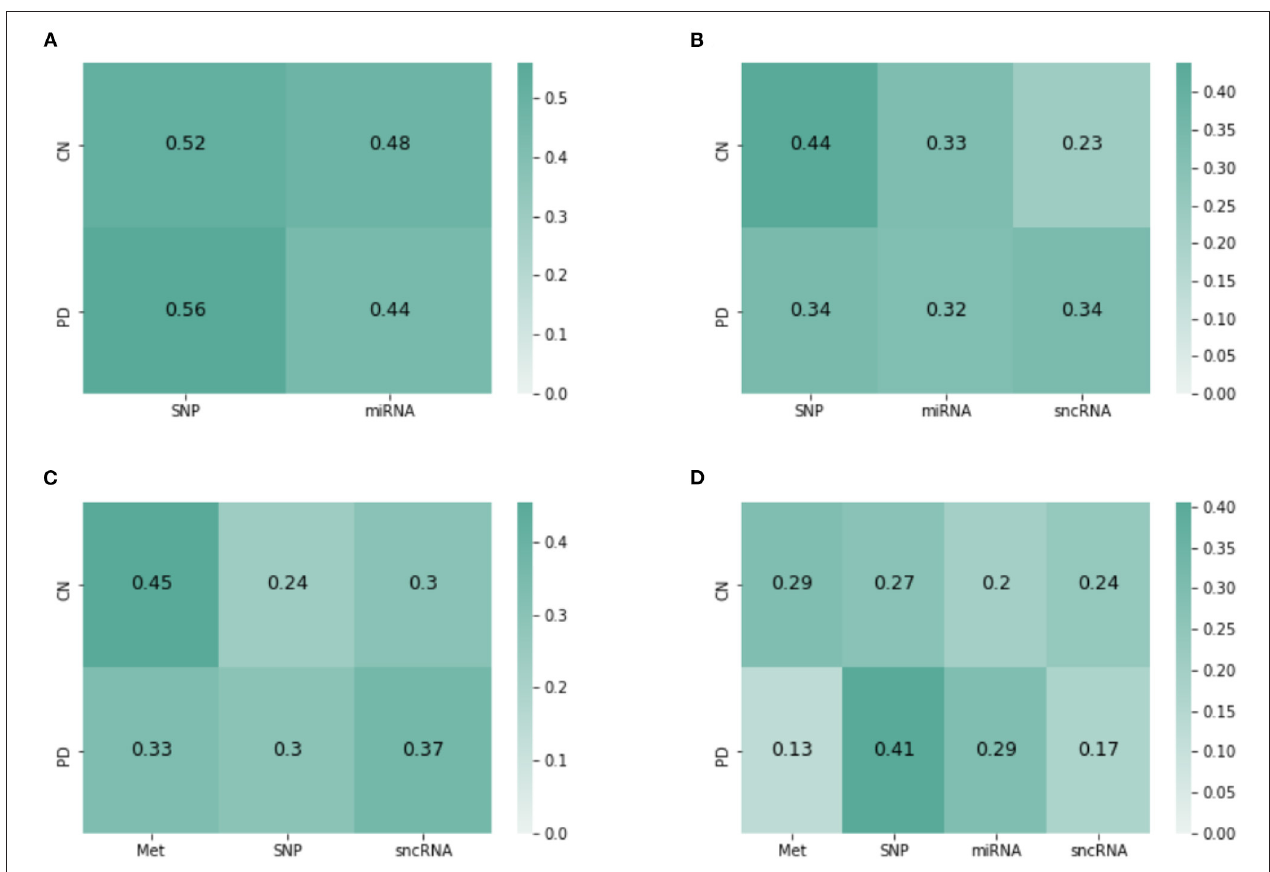
FIGURE 4 | Attention matrices from JOIN-GCLA for the omics combination of (A) SNP-miRNA, (B) SNP-miRNA-sncRNA, (C) Met-SNP-sncRNA (D)